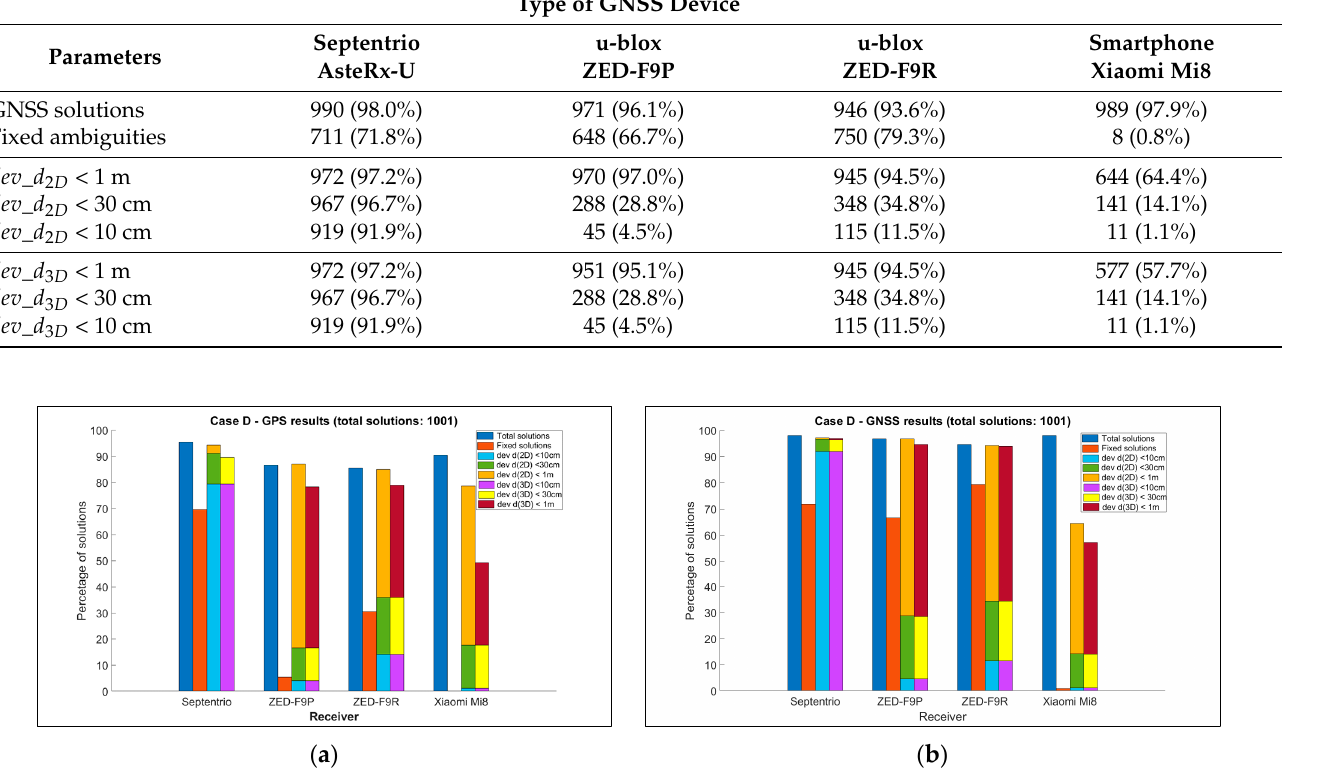
Figure 16. Percentage of solutions for Case D for ( a ) GPS solutions; ( b ) GNSS solutions. Each bar in a group shows: available solutions (1st bar), percentage of fixed solutions (2nd bar), deviation at horizontal distances (3rd bar, where light blue is for thresholds less than 10 cm, green is for thresholds less than 30 cm, and brown is for thresholds less than 1 m), and 4th bar shows deviation at spatial distances (yellow, green, and dark red for 10 cm, 30 cm, and 1 m thresholds, respectively).